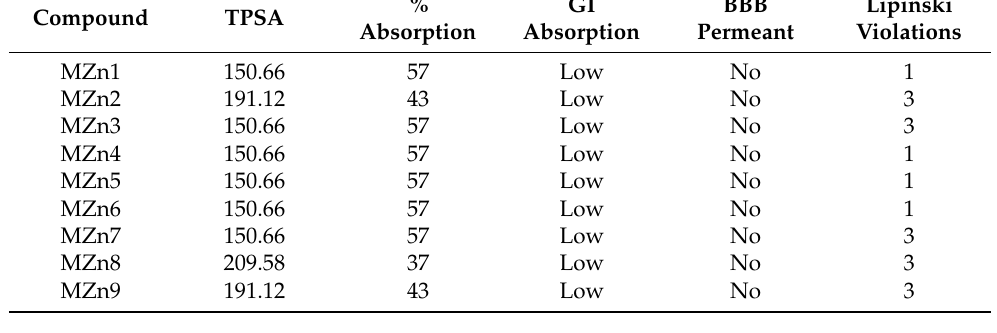
Table 3. Swiss ADME of MZn1–MZn9.